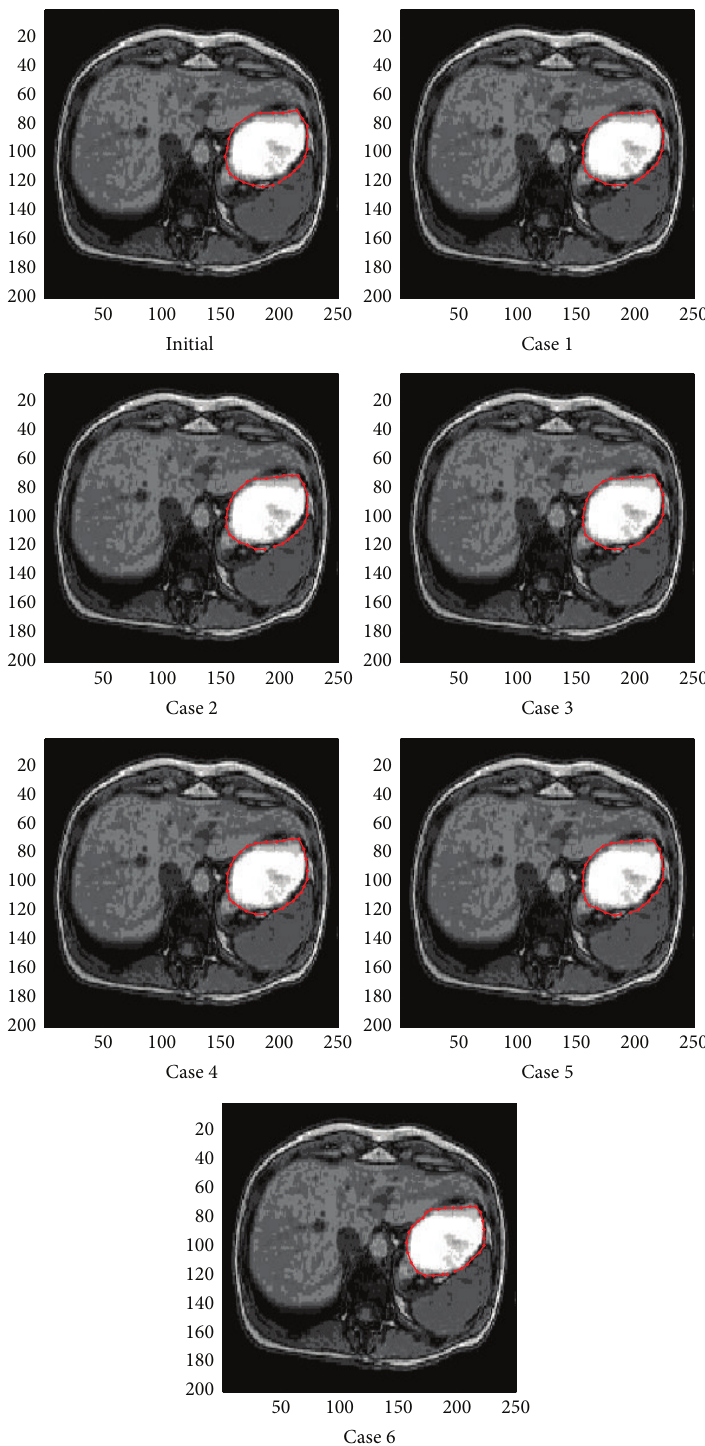
Figure 15: Active contour model implementation by “multipopulation PSO” method for different cases of inertia. Results for “MRI” image with control points = 30, 𝛼 = 0.17 , 𝛽 = 0.15 , and Γ = 0.20